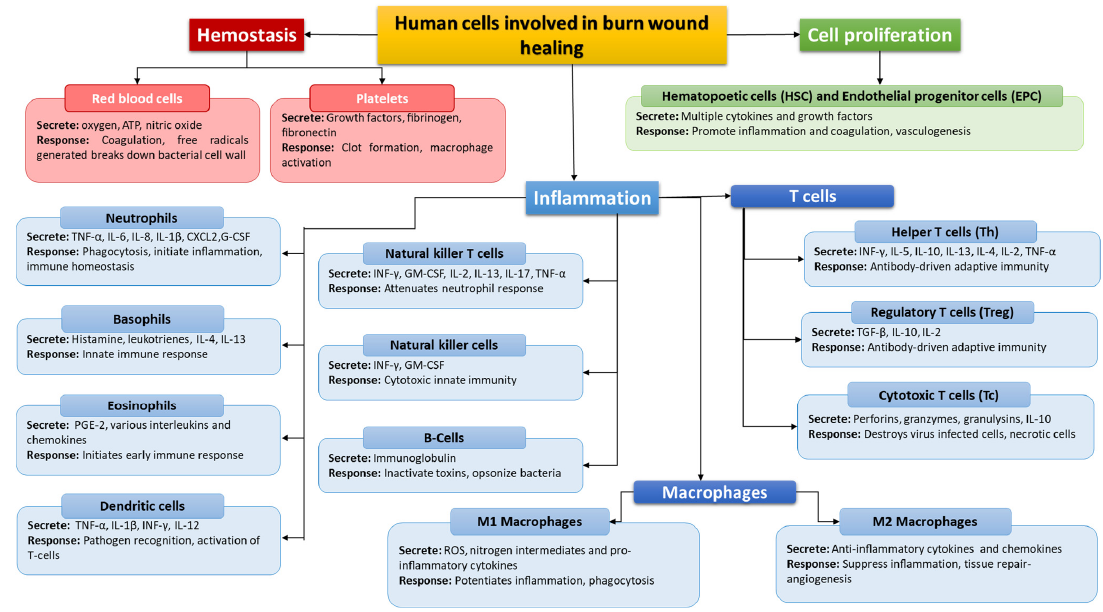
Figure 4. Human cells involved in burn wound healing based on